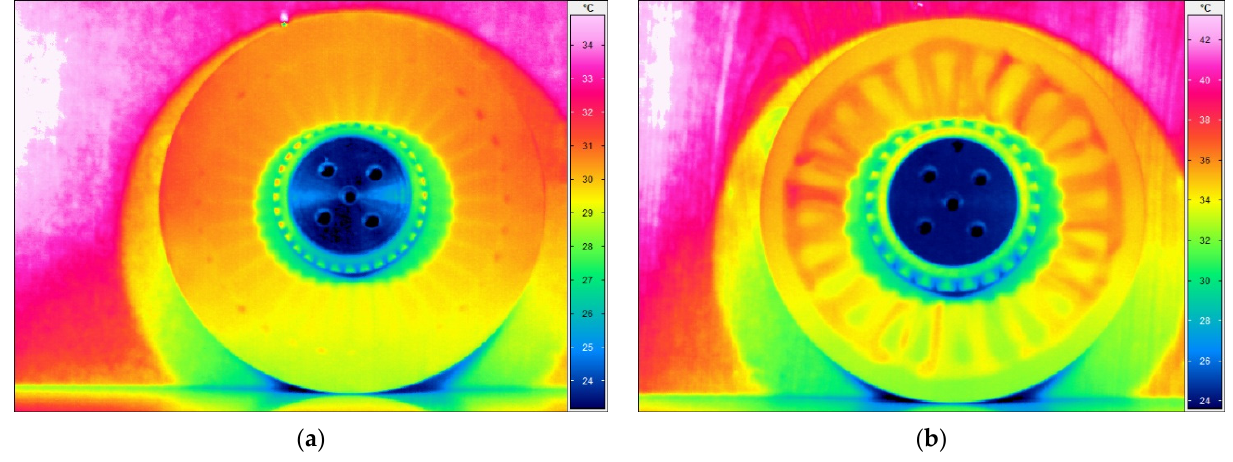
Figure 12. The representative thermograms of the ( a ) larger and ( b ) smaller disks.